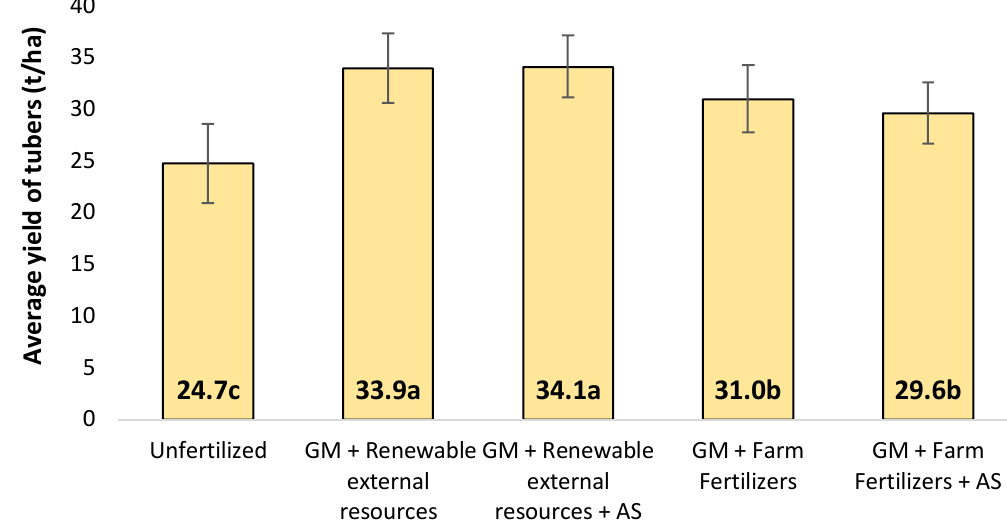
Figure 3. Potato tubers yield (observed treatments, 2016). Error bars represent the standard error (SE). Different letters mean statistical difference ( p ≤ 0.5).